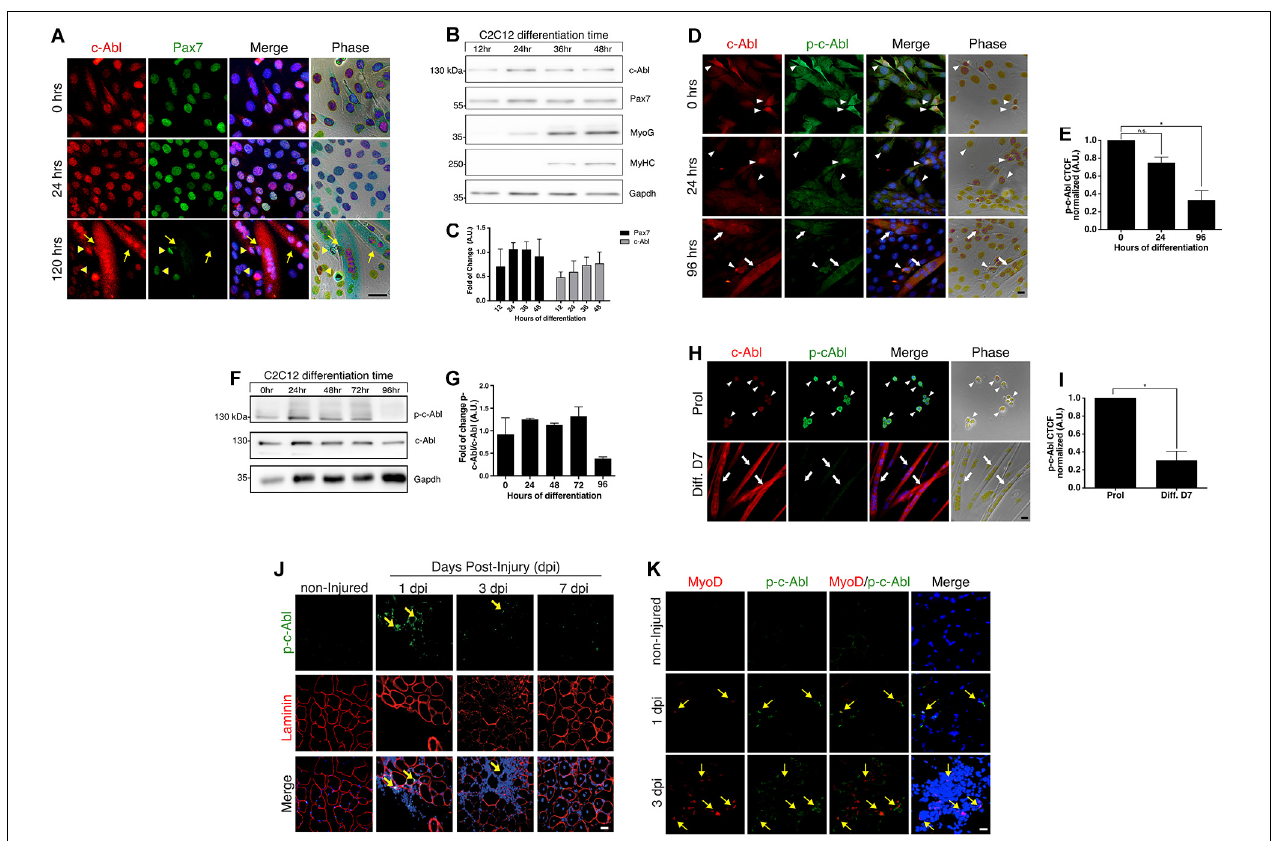
FIGURE 1 | c-Abl is expressed in myoblasts and activated during muscle regeneration. (A) Pax7 and c-Abl nuclear expression are correlated. C2C12 cells were differentiated the indicated time and then fixed. IF was performed against c-Abl (red), Pax7 (green), and nuclei were stained with Hoechst 33342 (blue). Arrows show myotubes without Pax7 expression, while arrowheads show mononucleated cells expressing Pax7 and c-Abl. Scale bar: 10 µ m. (B) Expression of Pax7 and c-Abl in early myoblast differentiation. C2C12 cells were maintained in differentiation conditions for the indicated times and lysed. WB against Pax7, c-Abl, Myogenin (MyoG), MyHC and Gapdh was performed. (C) Graph shows quantification of Pax7 and c-Abl protein levels from B ( n = 4). A.U., arbitrary units. (D) Expression and phosphorylation of c-Abl in C2C12. Cells were induced to differentiate, and IF for c-Abl (red) and phospho-tyr412 c-Abl (p-c-Abl, green) was performed at the indicated times. Nuclei were stained with Hoechst 33342 (blue). Arrows show myotubes and arrowheads myoblasts. Scale bar: 10 µ m. (E) Quantification of (D) . Graph shows quantification of Corrected Total Cell Fluorescence (CTCF) for p-c-Abl normalized to 0 h ( n = 3, * P -value < 0.05, Kruskal–Wallis test, ns, not significant) A.U., arbitrary units. (F) Expression of p-c-Abl and c-Abl in myoblast differentiation. C2C12 cells were maintained in differentiation conditions for the indicated times and lysed. WB against p-c-Abl, c-Abl, and Gapdh was performed. (G) Graph shows quantification of Pax7 and c-Abl protein levels from F ( n = 2). A.U., arbitrary units. (H) Expression and phosphorylation of c-Abl in primary myoblasts. Cells were maintained in proliferation conditions (Prol) or 7 days in differentiation conditions (Diff. D7), followed by IF for c-Abl (red) and p-c-Abl (green). Nuclei were stained with Hoechst 33342 (blue). Arrows show myotubes and arrowheads myoblasts. Scale bar: 10 µ m. (I) Quantification of (H) . Graph shows quantification of CTCF for p-c-Abl normalized to proliferation ( n = 3, * P -value < 0.05, Wilcoxon signed-rank test). A.U., arbitrary units. (J) c-Abl is transiently phosphorylated in early muscle regeneration. Sections of muscles were obtained at 0 (non-injured), 1, 3, and 7 dpi, fixed and IF for p-c-Abl (green) and laminin (red) was performed. Nuclei were stained with Hoechst 33342 (blue). Yellow arrows show p-c-Abl in cells associated with laminin. Scale bar: 50 µ m. (K) Myogenic cells are positive for p-c-Abl. Muscle cryosections were obtained at 0 (non-injured), 1, and 3 dpi, fixed and IF for p-c-Abl (green), and MyoD (red) was performed. Nuclei were stained with Hoechst 33342 (blue). Yellow arrows show MyoD positive cells with expression of p-c-Abl. Scale bar: 50 µ